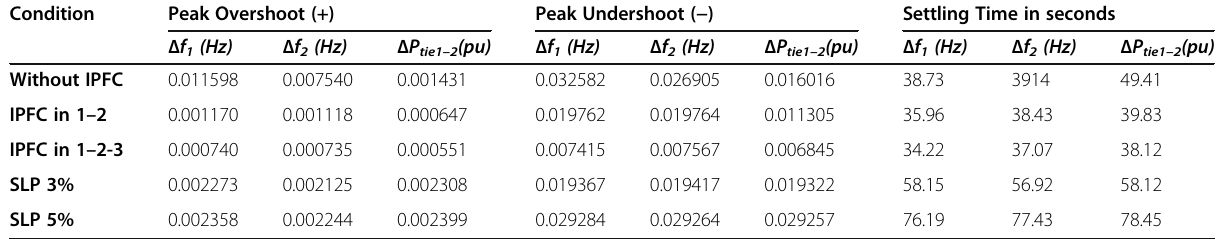
Table 5 Peak deviation and settling time for GOA optimized PDF plus (1 + PI) controller with IPFC and different SLP values Condition